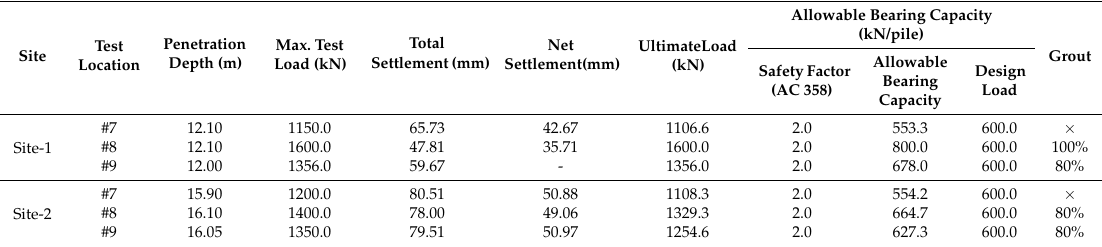
Table 2. Results of the static load test for each site.